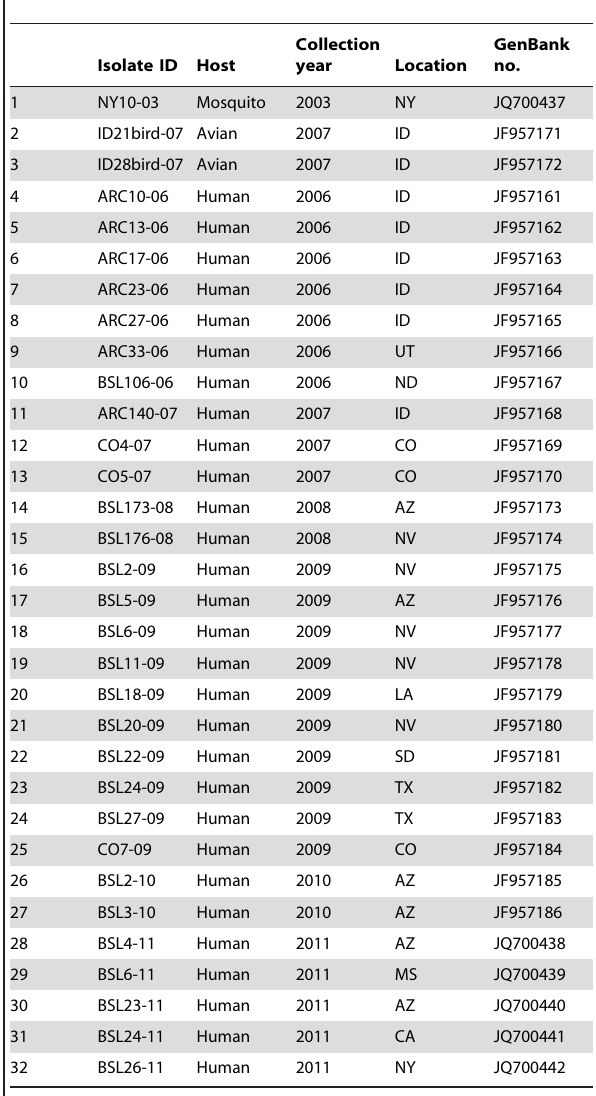
Table 1. List of WNV isolates completely sequenced in this